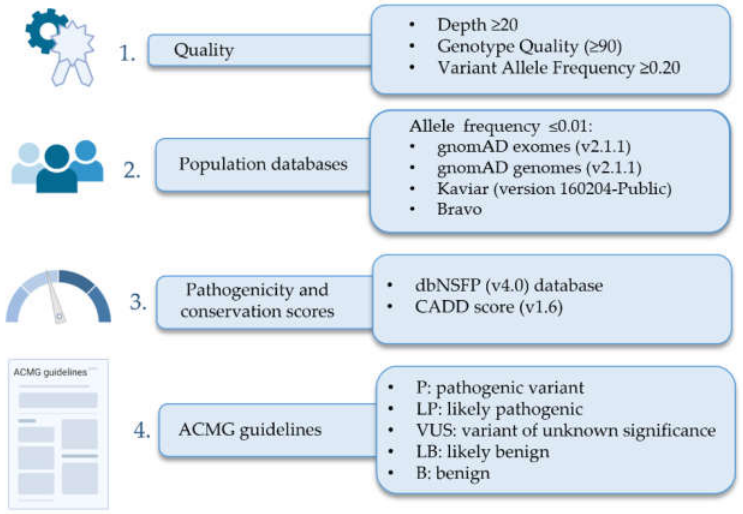
Figure 1. Filter algorithm designed to analyze SNVs variants detected by whole exome sequencing analysis.